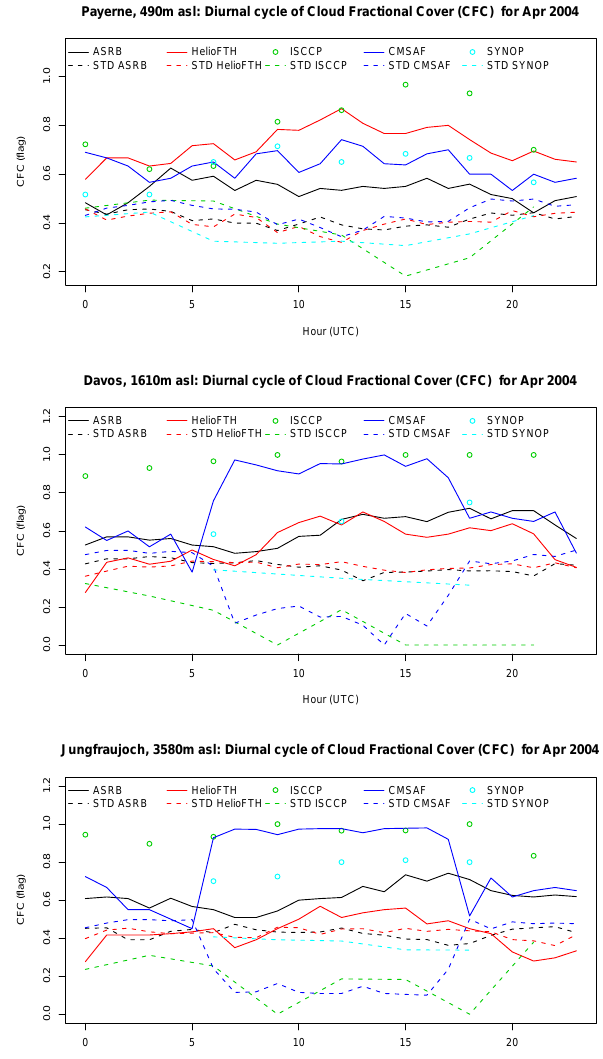
Fig. 2. Mean diurnal cycle of CFC and its standard deviation (STD) for ASRB sites for April 2004.